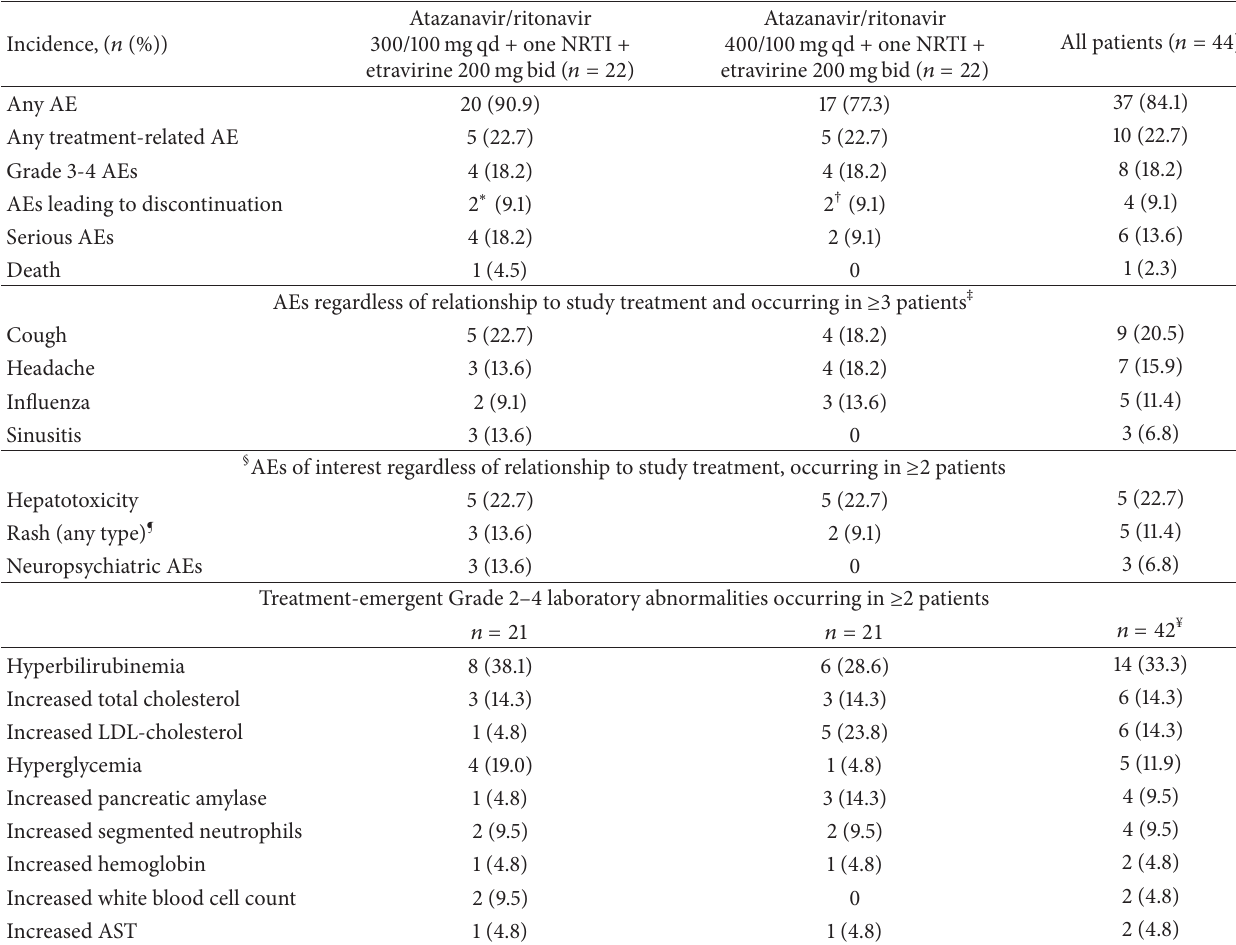
Table 4: Overview of AEs and laboratory abnormalities during the 48-week treatment session. Incidence, (𝑛